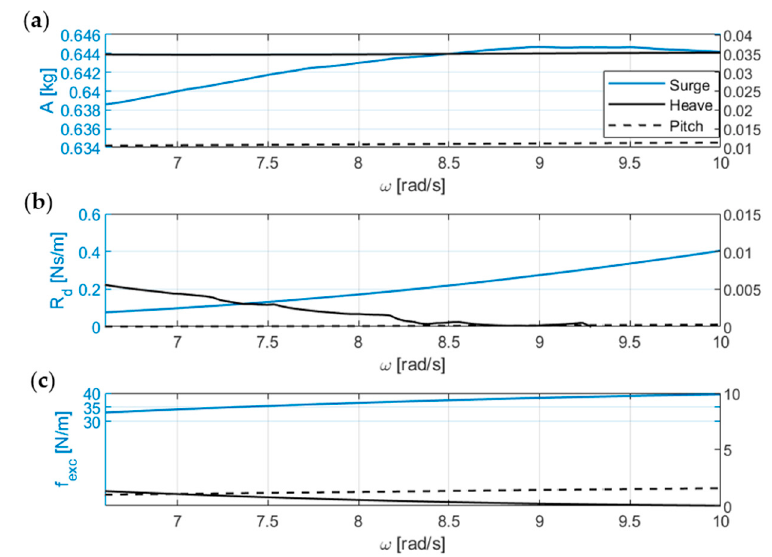
Figure 5. Added mass A ( a ), radiation damping R d ( b ) and excitation force f exc ( c ) coefficients for